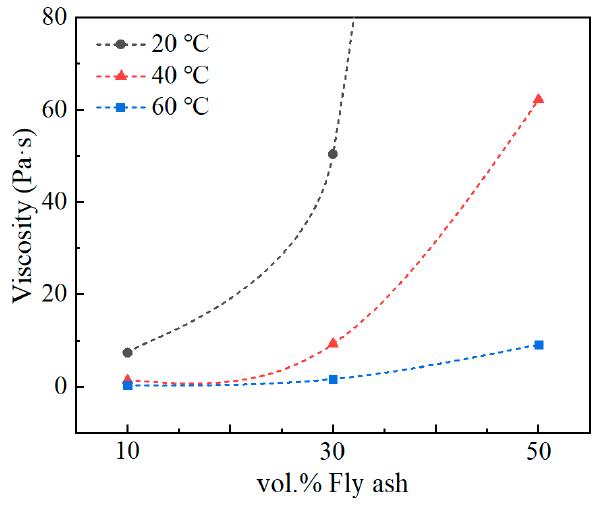
Figure 3. Viscosity distribution with fly ash content for composites at different temperature: ( ● ) 20 °C, ( ▲ ) 40 °C and ( ■ ) 60 °C.